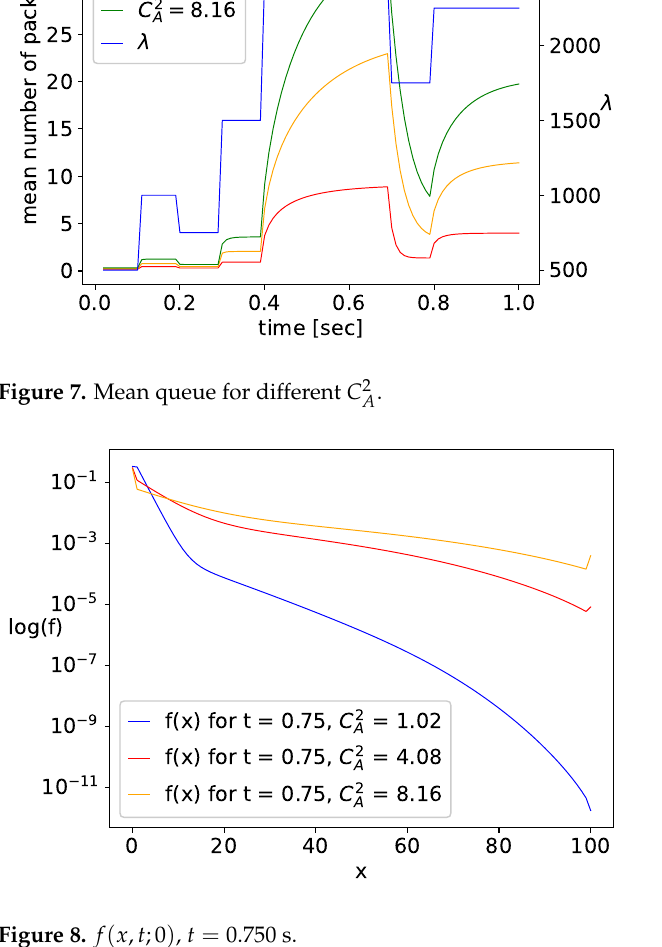
Figure 8. f ( x , t ;0 ) , t = 0.750